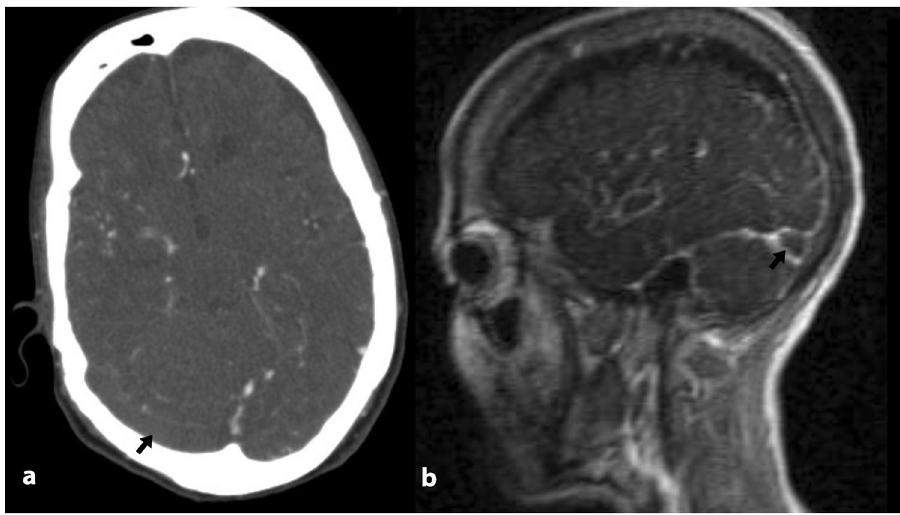
Figure 1. ( a ) Axial brain CT angiography shows filling defect in the right transverse sinus (black arrow). ( b ) Sagittal contrast enhanced brain MR venography shows filling defect in the right transverse sinus (white